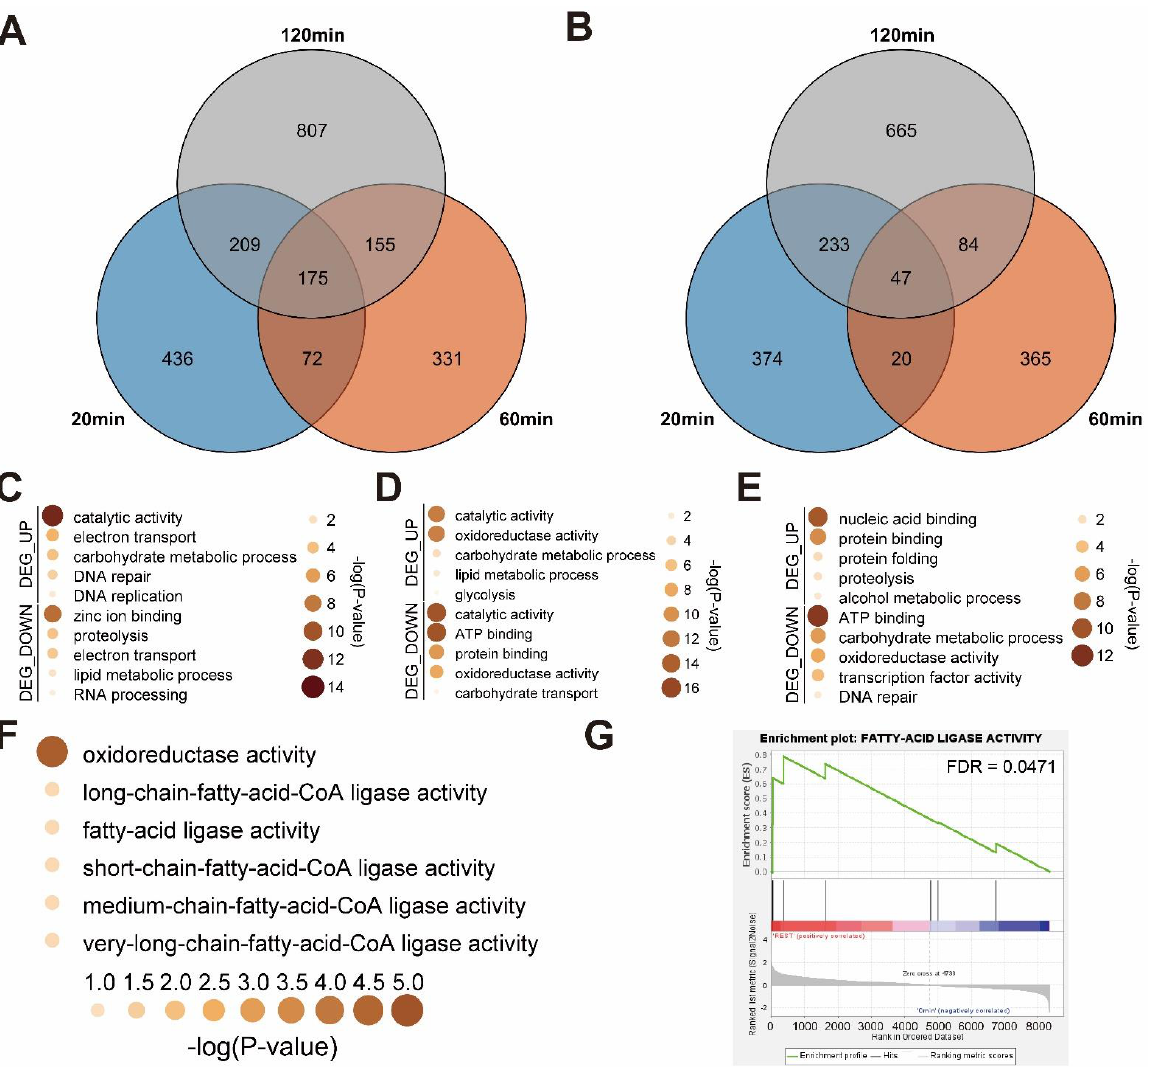
Figure 3. DEG analysis and functional annotation of DEGs of A. bisporus strain KMCC00540 under mechanical stress conditions. ( A ) Venn diagram analysis to visualize 20, 60, and 120 min dependent up-regulated DEGs. ( B ) Venn diagram analysis to visualize 20, 60, and 120 min dependent down- regulated DEGs. ( C – F ) GO analysis of identified DEGs. Up-regulated DEGs are indicated as DEG_UP, down-regulated DEGs are indicated as DEG_DOWN. ( C ) GO terms for DEGs at 20 min. ( D ) GO terms for DEGs at 60 min. ( E ) GO terms for DEGs at 120 min. ( F ) GO terms for common up-regulated DEGs under three conditions. ( G ) Gene-set enrichment analysis of fatty-acid ligase activity genes in mechanical stimulus treated samples compared with non-treated